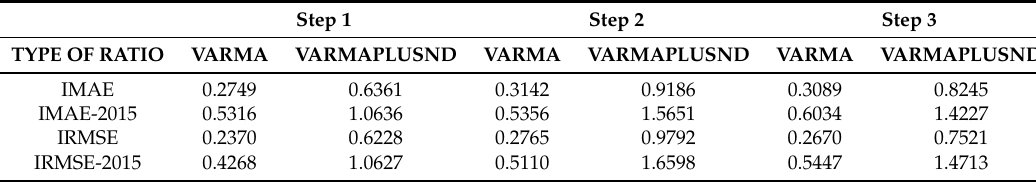
Table 3. Comparison of mean absolute error and root mean squared error with expanding window applied to the VARMA using only hard data and both hard data and soft data, respectively (i.e., ISTAT survey), about the non-durable goods. The forecast windows expands itself from 2008:01 to 2018:12. The ratio between MAEs and RMSEs with respect to the benchmark are shown. A value less than one indicates an improvement over the